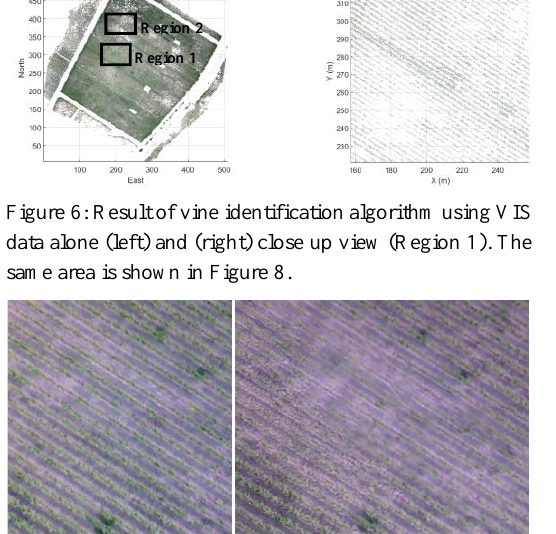
Figure 7: Expanded view of the raw imagery (left) and DPC (right) of Region 2 (Figure 6)